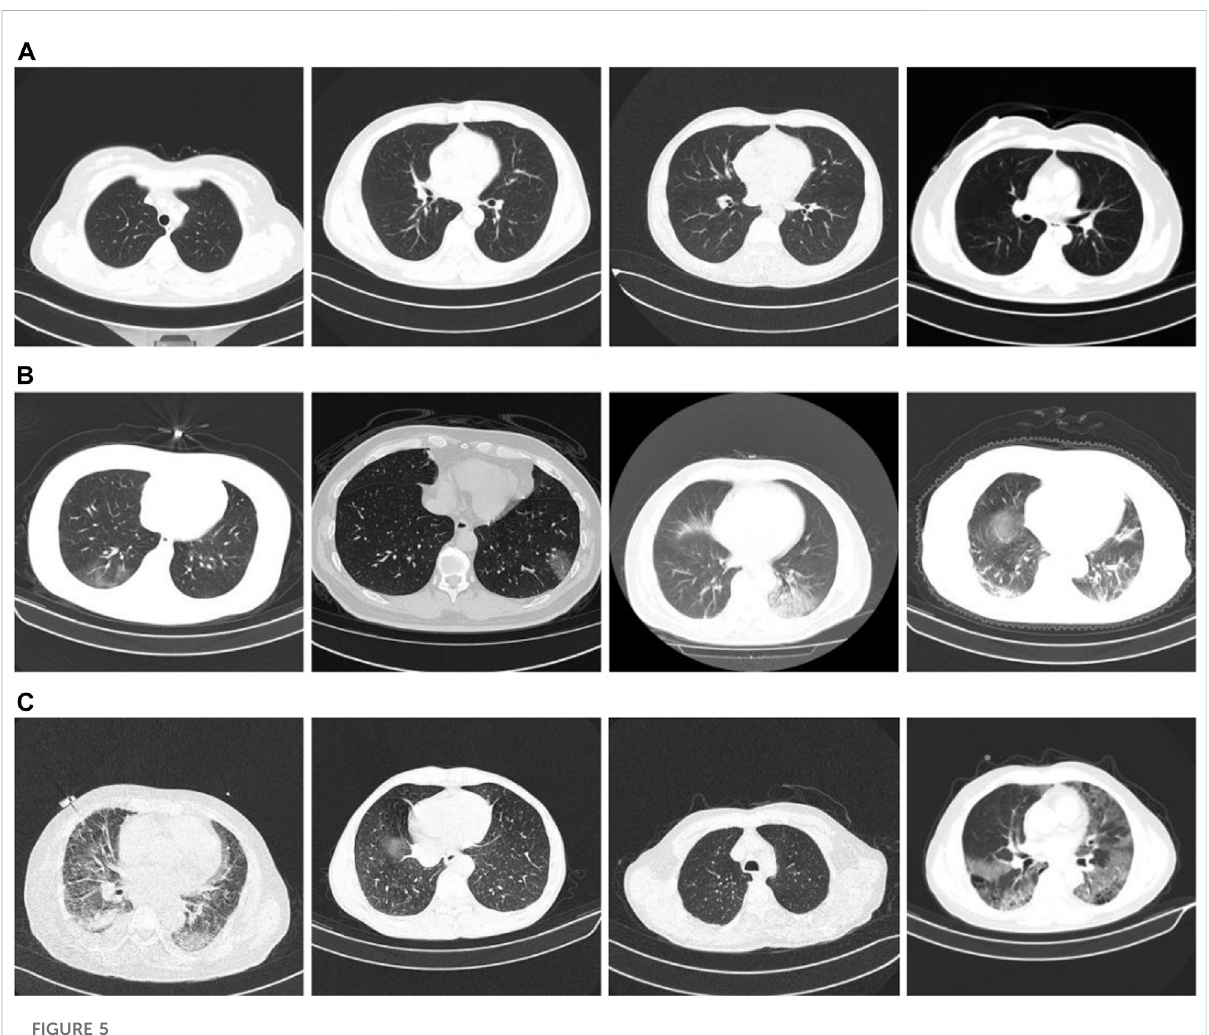
FIGURE 5 CC-CCII chest CT images. (A) Normal conditions; (B) COVID-19; (C)